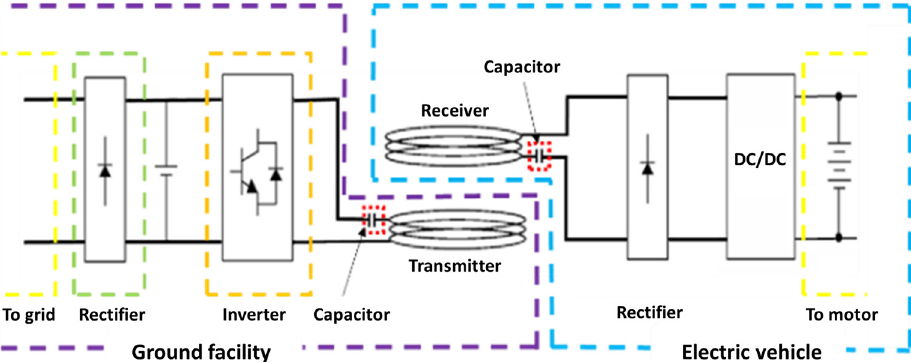
Figure 2. Typical WPT charging system for EVs.